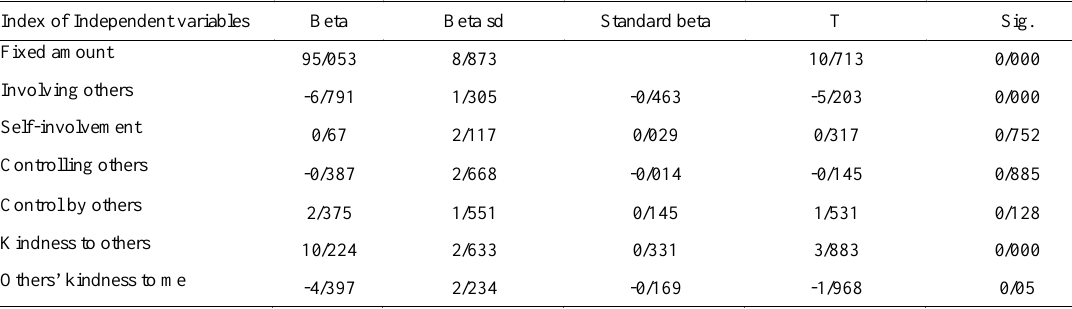
Table 5: Results of regression coefficients, organizational commitment and personal